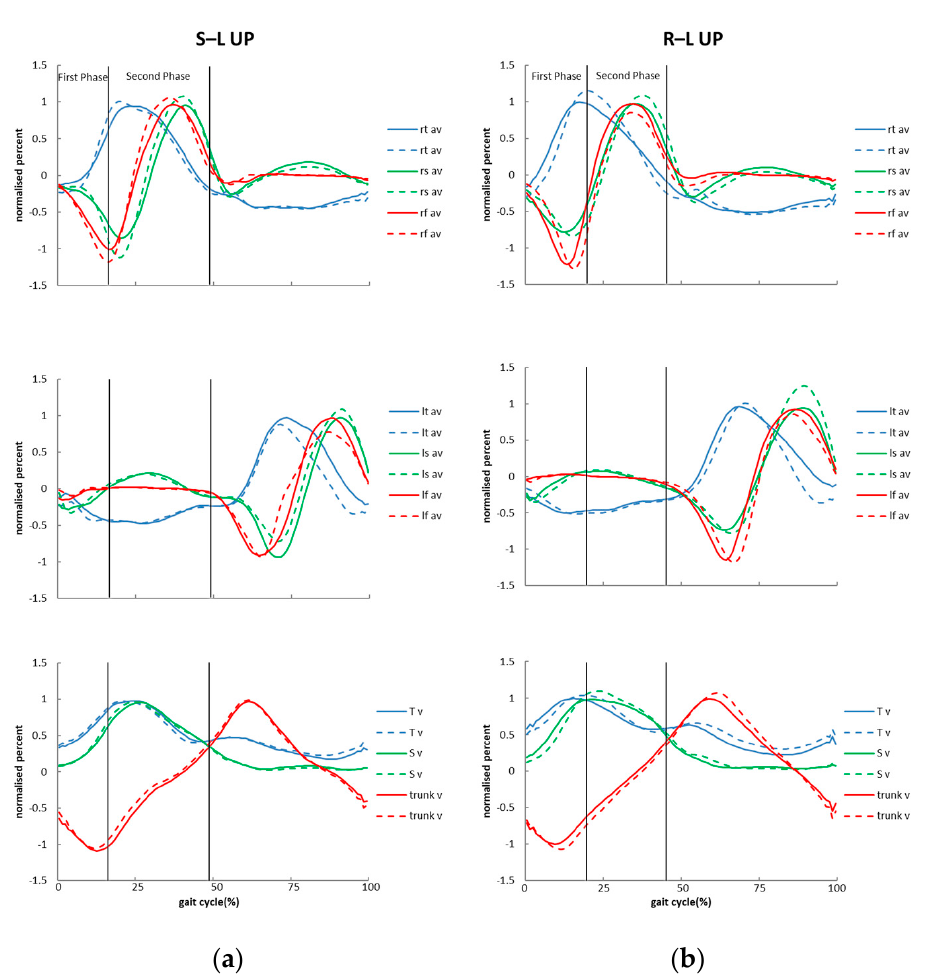
Figure 3. Average profile of the parameters: ( a ) during S-L UP and ( b ) during R-L UP. rt indicates the hip of leading limb, lt indicates the hip of trailing limb, rs indicates the knee of leading limb, ls indicates the knee of trailing limb, rf indicates the ankle of leading limb, lf indicates the ankle of trailing limb, trunk is trunk, T indicates the thigh of the leading limb, S indicates the shank of the leading limb, aa indicates angular acceleration, av indicates angular velocity, a indicates acceleration, and v indicates velocity. The dashed lines indicate transition stride. The solid lines indicate the stride before transition